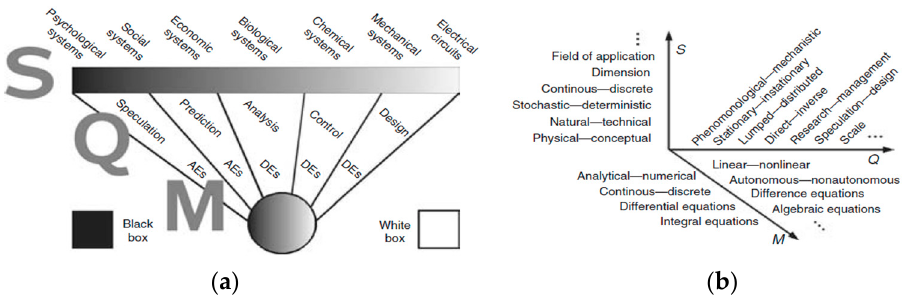
Figure 2. The three dimensions of an SQM mathematical model, where the (S) systems are ranked at the top of the bar; immediately below the bar, there is a list of objectives that the mathematical models in each of the segments can have (which is Q); at the lower end are the corresponding mathematical structures (M) ranging from algebraic equations (Aes) to differential equations (Des). ( a ) Classification of mathematical models between black and white box models. ( b ) Classification of mathematical models in the SQM space. Modified from